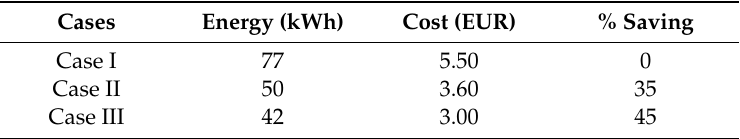
Table 6. Comparison of the proposed and existing energy, and cost management within case-I, II, and III.